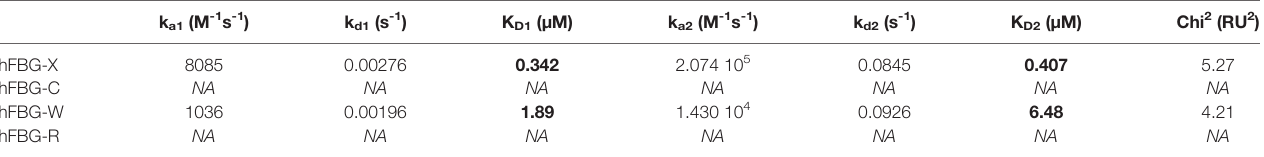
TABLE 3 | Kinetic and dissociation constants derived from SPR